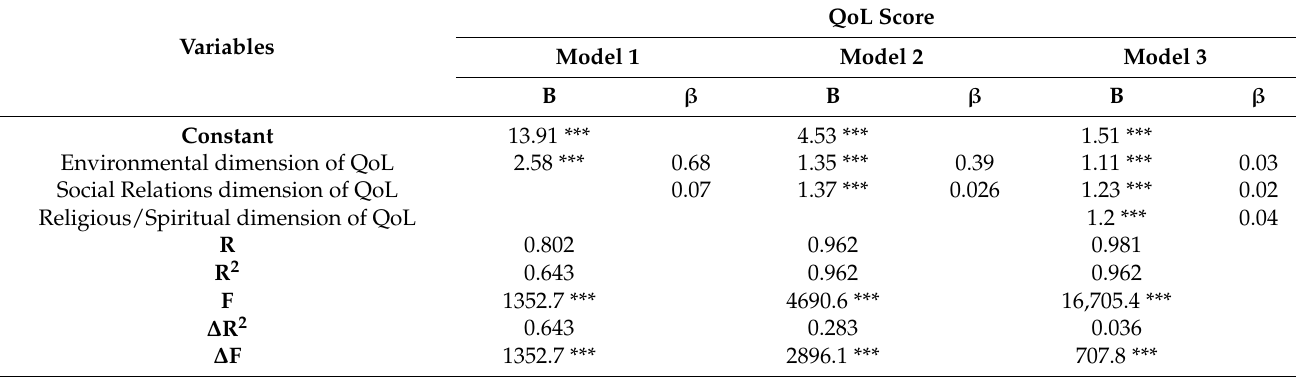
Table 3. The hierarchical multiple regression predicting the QoL score from different QoL dimensions during the COVID-19 pandemic.